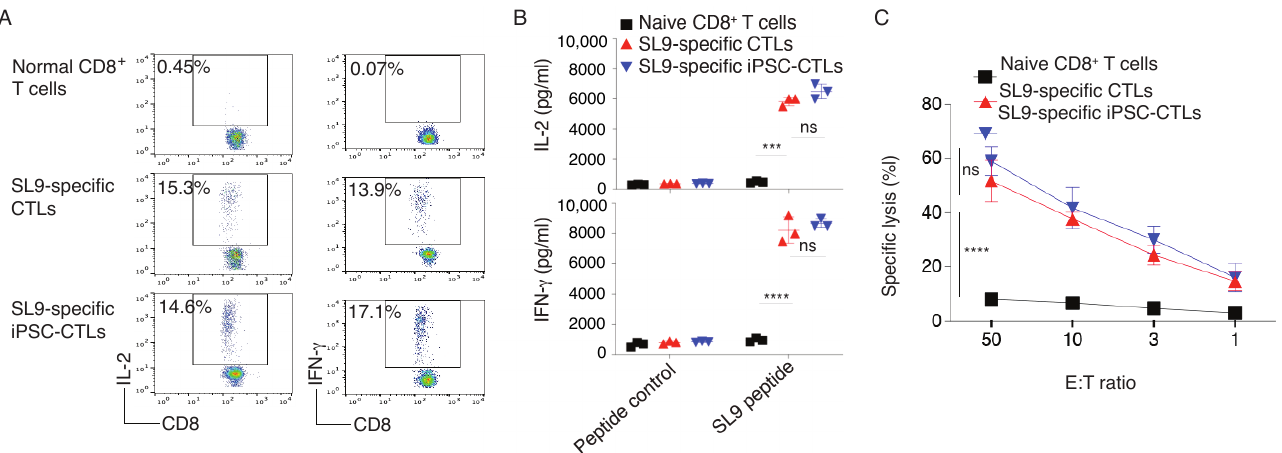
Figure 2. Functional analysis of SL9-specific iPSC-CTLs. On day 28 of in vitro co-culture, the SP CD8 + iPSC-T cells were sorted. The iPSC-T cells and CD8 + T cells transduced with MiDR-SL9 TCR were stimulated by T-depleted splenocytes (APCs) from HHD mice and pulsed with SL9 peptide (SLYNTVATL). ( A ) Intracellular staining of IL-2 and IFN- γ after 7 h (gated on CD8 + cells) (T/APCs = 1:4). Data shown are representative of three individual experiments ( n = 3). ( B ) ELISA of IL-2 and IFN- γ after 40 h. The values represent mean ± S.E.M. (***, p < 0.001, ****, p < 0.0001; ns, p > 0.05. Unpaired t tests). ( C ) T cell cytotoxicity was measured after co-culture for 6 h using the 7-AAD/CFSE cell-mediated cytotoxicity assay kit. The values represent mean ± S.E.M. (****, p < 0.0001; ns, p > 0.05. Nested one-way